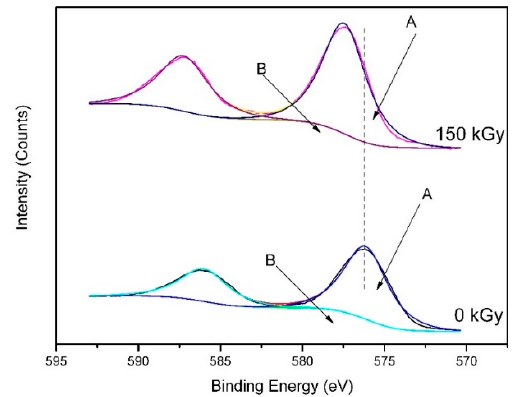
Figure 7. XPS spectrum of the Cr2p energy region for the powders (1000 °C, 1 h) before and after gamma ray irradiation.